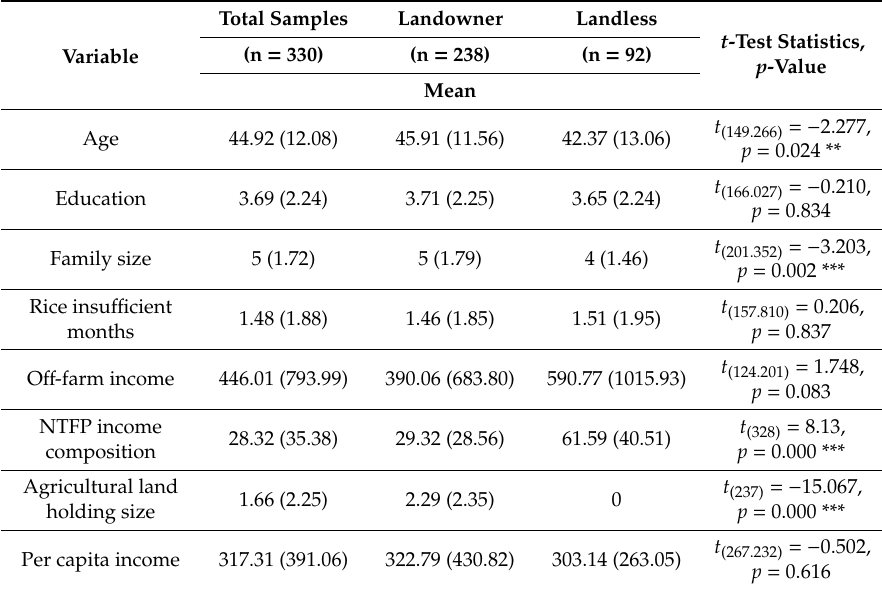
Table 3. Description of socio-economic characteristics of sampled households.